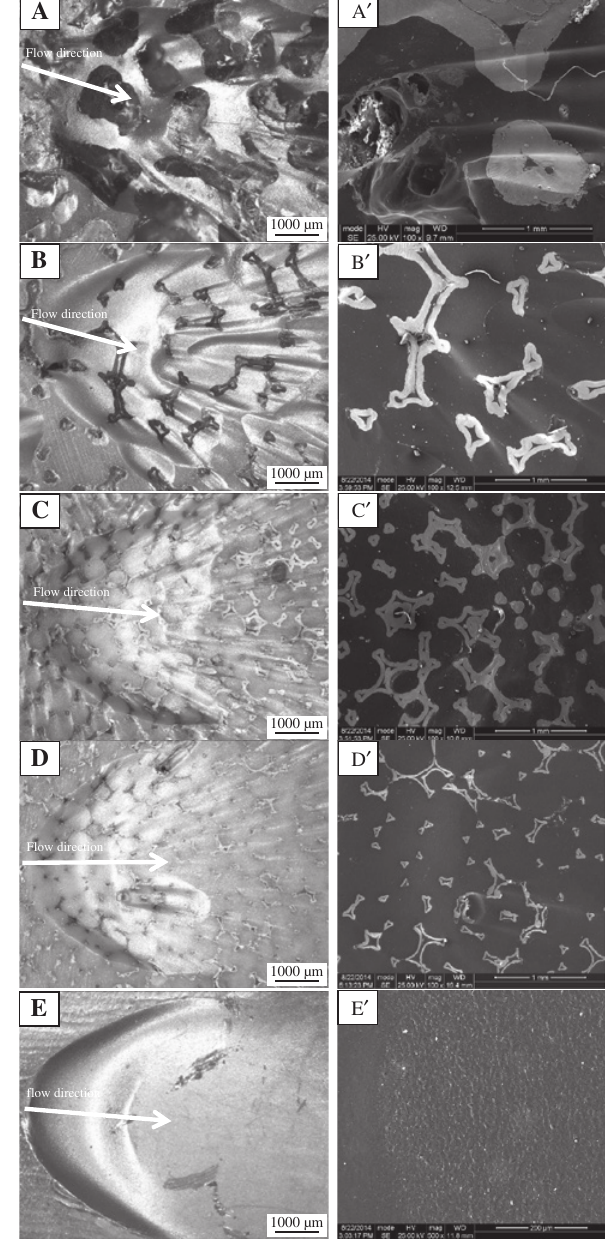
Figure 7: Morphologies of PEEK/Ni foam composites and pure PEEK after erosion-corrosion test with an impact angle of 30 ° observed using optical microscopy (A–E) and SEM (A ′ –E ′ ): (A and A ′ ) PEEK/ Ni25, (B and B ′ ) PEEK/Ni50, (C and C ′ ) PEEK/Ni100-1, (D and D ′ ) PEEK/Ni100-2, and (E and E ′ )